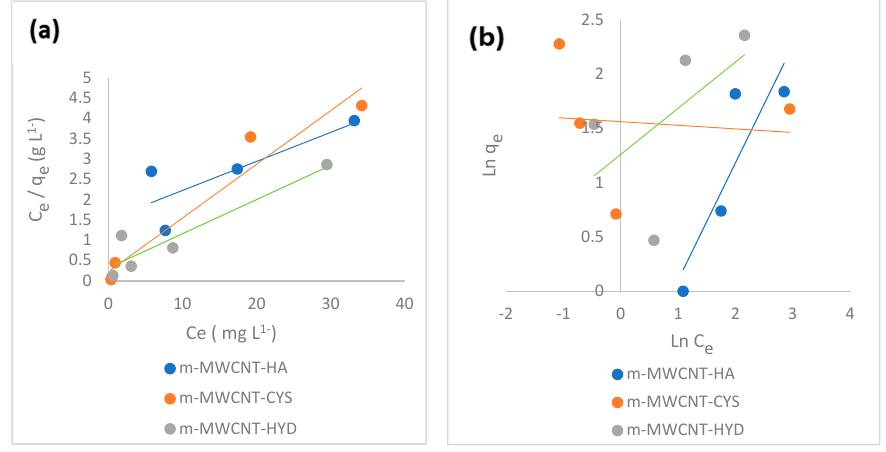
Figure 10. ( a ) Langmuir isotherm plot and ( b ) Freundlich isotherm plot for Ibu adsorption on m-MWCNT–HA, m-MWCNT–CYS, and m-MWCNT–HYD.